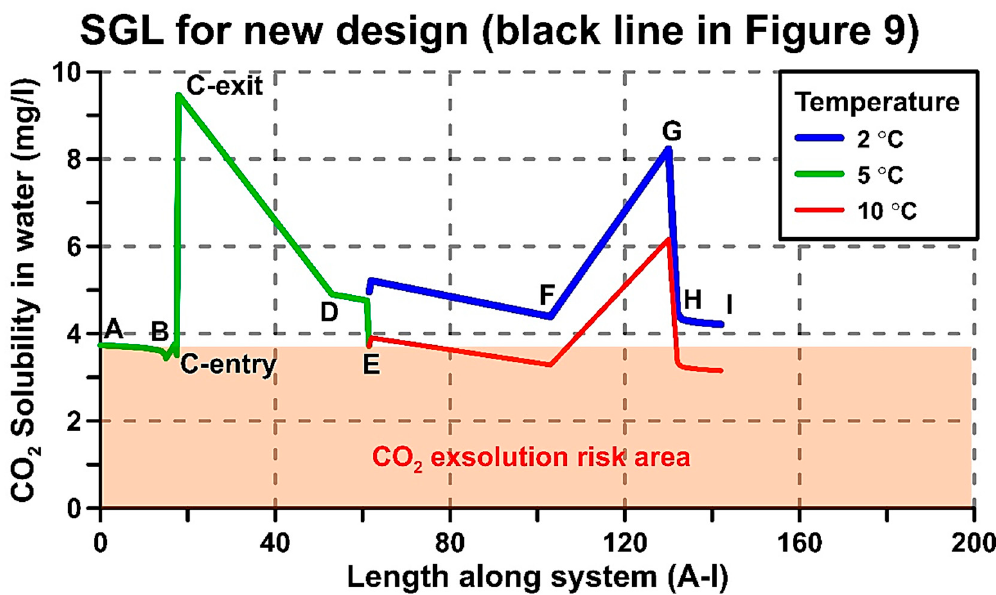
Figure 10. Solubility grade line (SGL) for the groundwater flow line A–I in Figure 8. The SGL is calculated from the black GPHGL (Figure 9) and the solubility of CO 2 in water (Figure 4). The backpressure valve is set to 3.0 bar. Return temperature after heat exchange is 2 °C for heating mode (blue) and 10 °C for cooling mode (red).